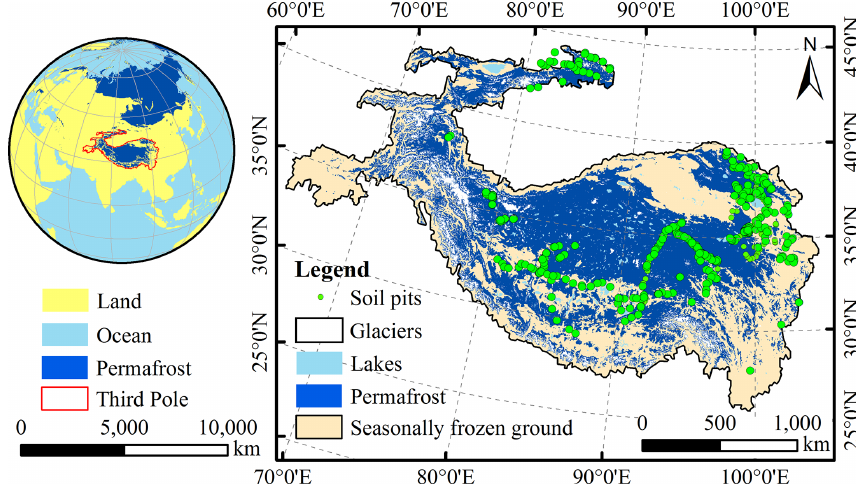
Figure 1. Distribution of soil pits in the Third Pole region (the frozen ground map is derived from Obu et al., 2019).